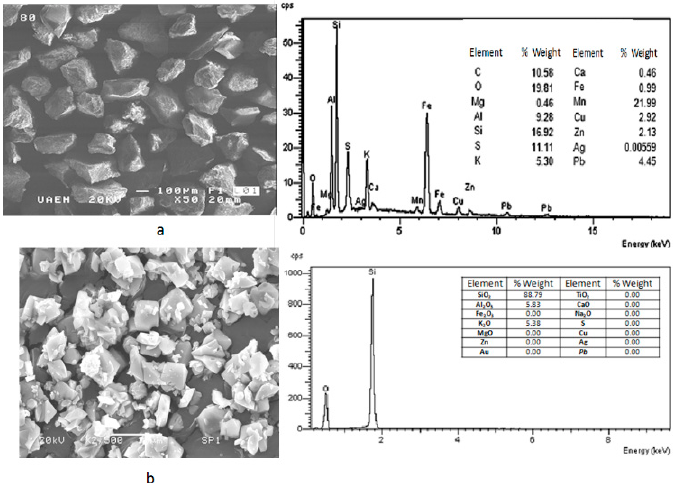
Figure 2. SEM-SE images and energy dispersive spectrometry (EDS) analysis executed on waste; ( a ) before flotation, and ( b ) after flotation process.